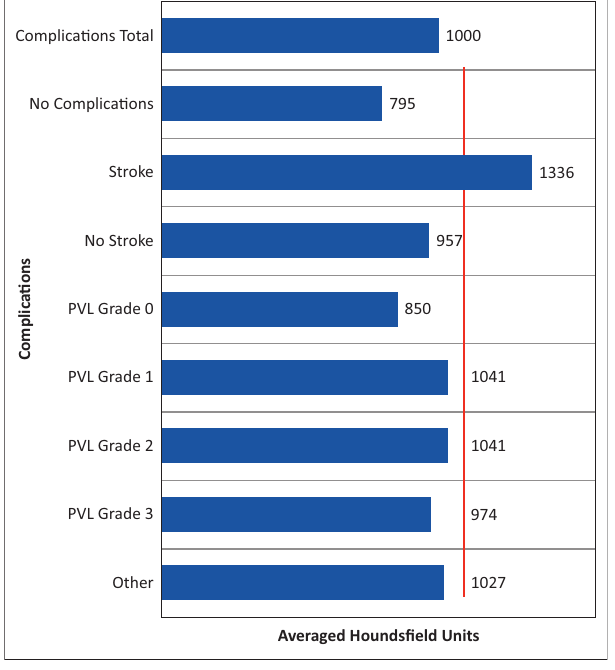
cardiac failure. FIGURE 6: Plaque characteristics v.